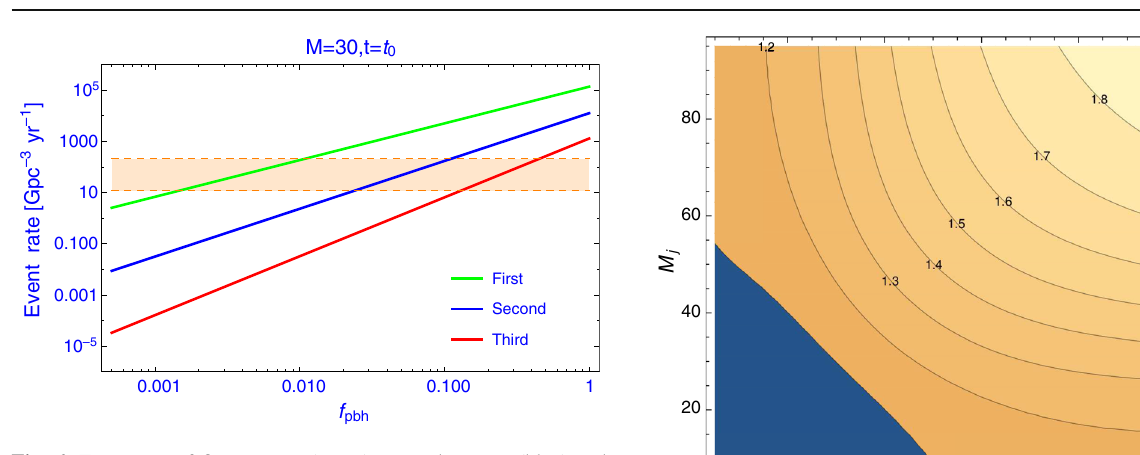
Fig. 6 Event rate of first merger (green), second merger (blue) and third merger (red) of PBH binaries with the mass 30 M (cid:2) at the present time as a function of the PBH abundance. The merger rate R = 12– 213 Gpc − 3 year − 1 , inferred by the LIGO and Virgo Collaboration, is shown as the shaded region colored orange [29]